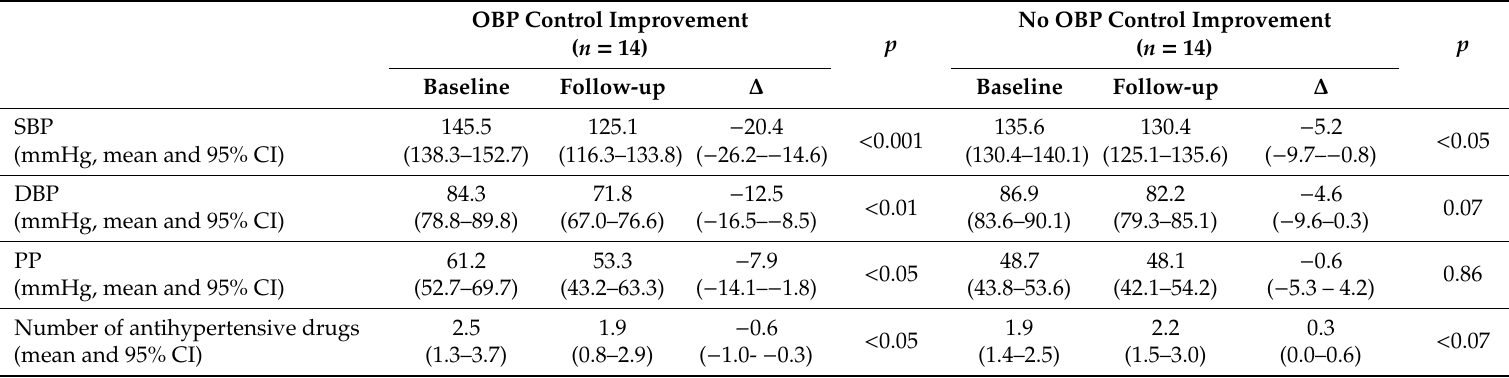
Table 2. O ffi ce BP measurements and antihypertensive treatment before and after successful DAA therapy, divided into two subgroups based on changes in OBP control after